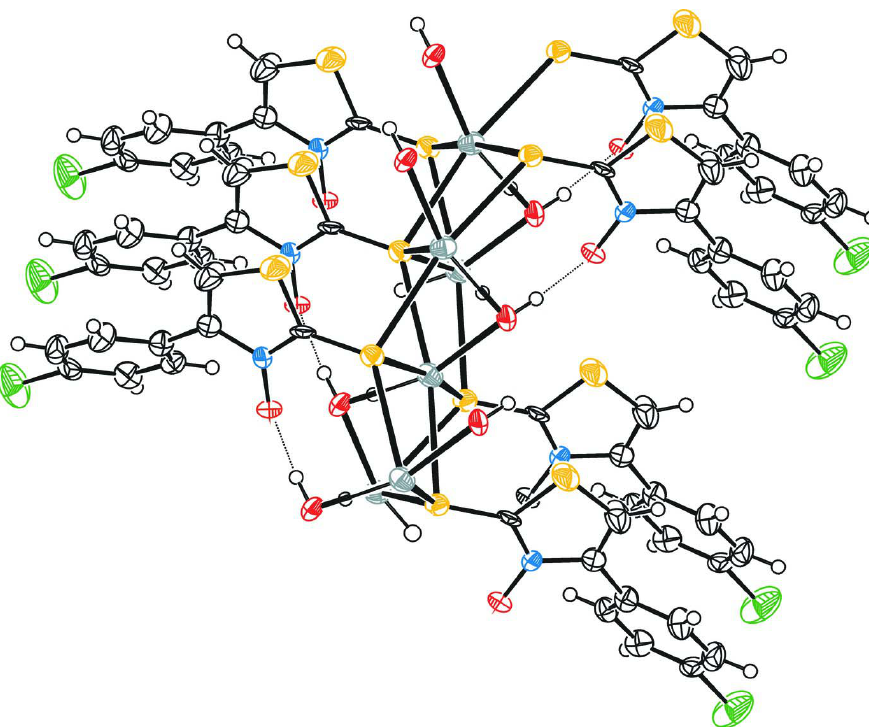
Figure 2 Packing and hydrogen bonding (dashed lines) of (I) in the solid state. S atoms are depicted in yellow, Cl in green, O in red, N in blue, and Na in